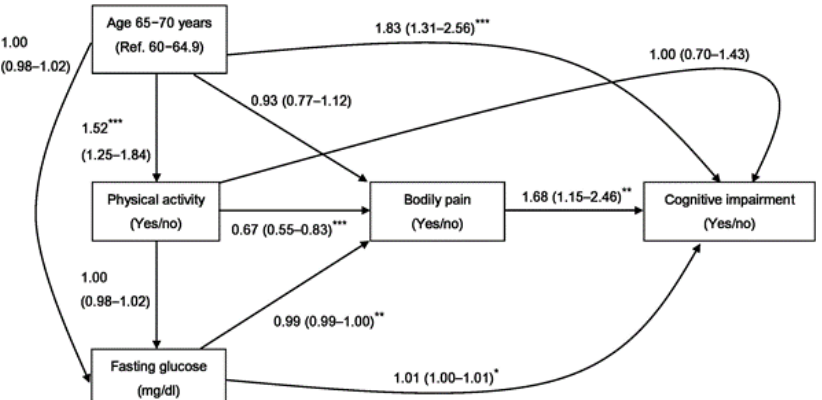
Figure 1. Potential causal pathway analysis between bodily pain and the occurrence of cognitive impairment among community-dwelling older adults. Values are expressed as odds ratio and 95% confidence interval. The models were adjusted for gender, marital status, alcohol drinking, smoking, physical activity, body mass index, waist circumference, total cholesterol, triglyceride, HDL cholesterol, LDL cholesterol, and eGFR by using logistic regression analyses. * p < 0.05, ** p < 0.01, *** p < 0.001. * = statistically significant.